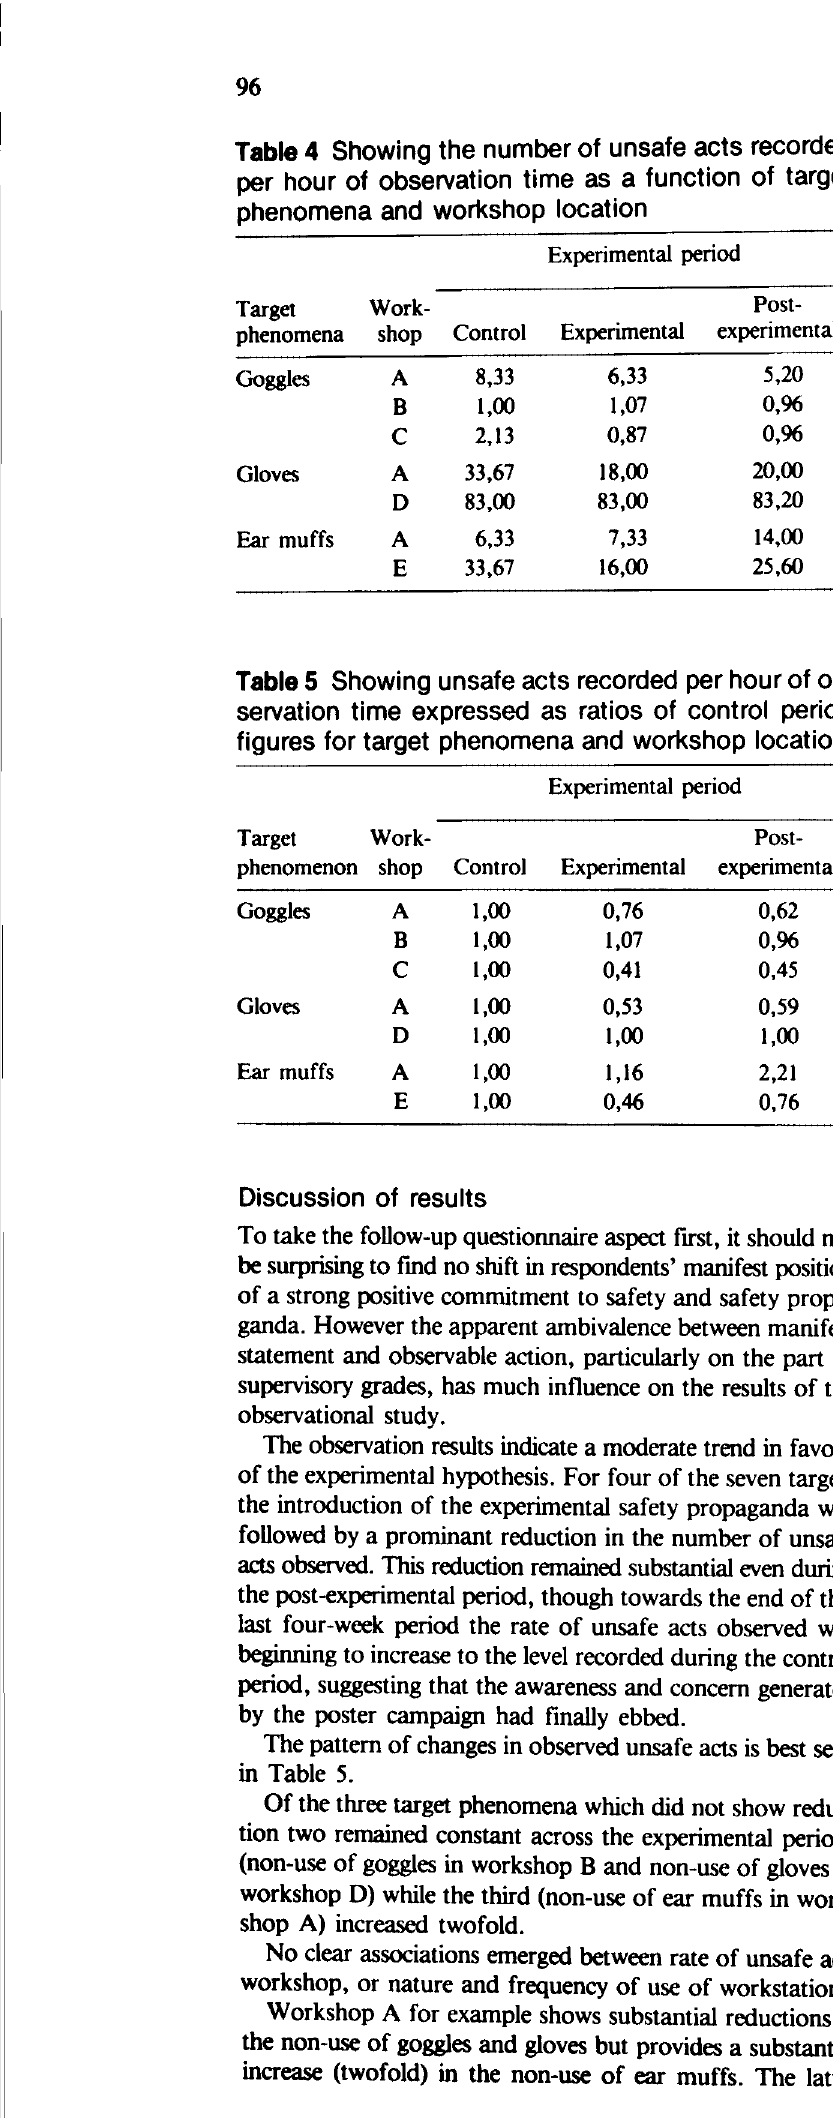
Table 4 Showing the number of unsafe acts recorded per hour of observation time as a function of target phenomena and workshop location